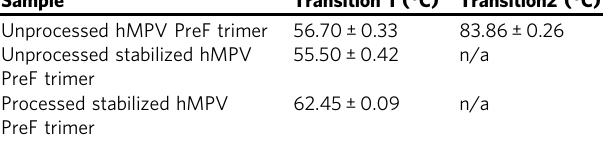
Table 2 Melting temperature (Tm) of unprocessed and processed hMPV F trimeric antigens determined by differential scanning fl uorimetry